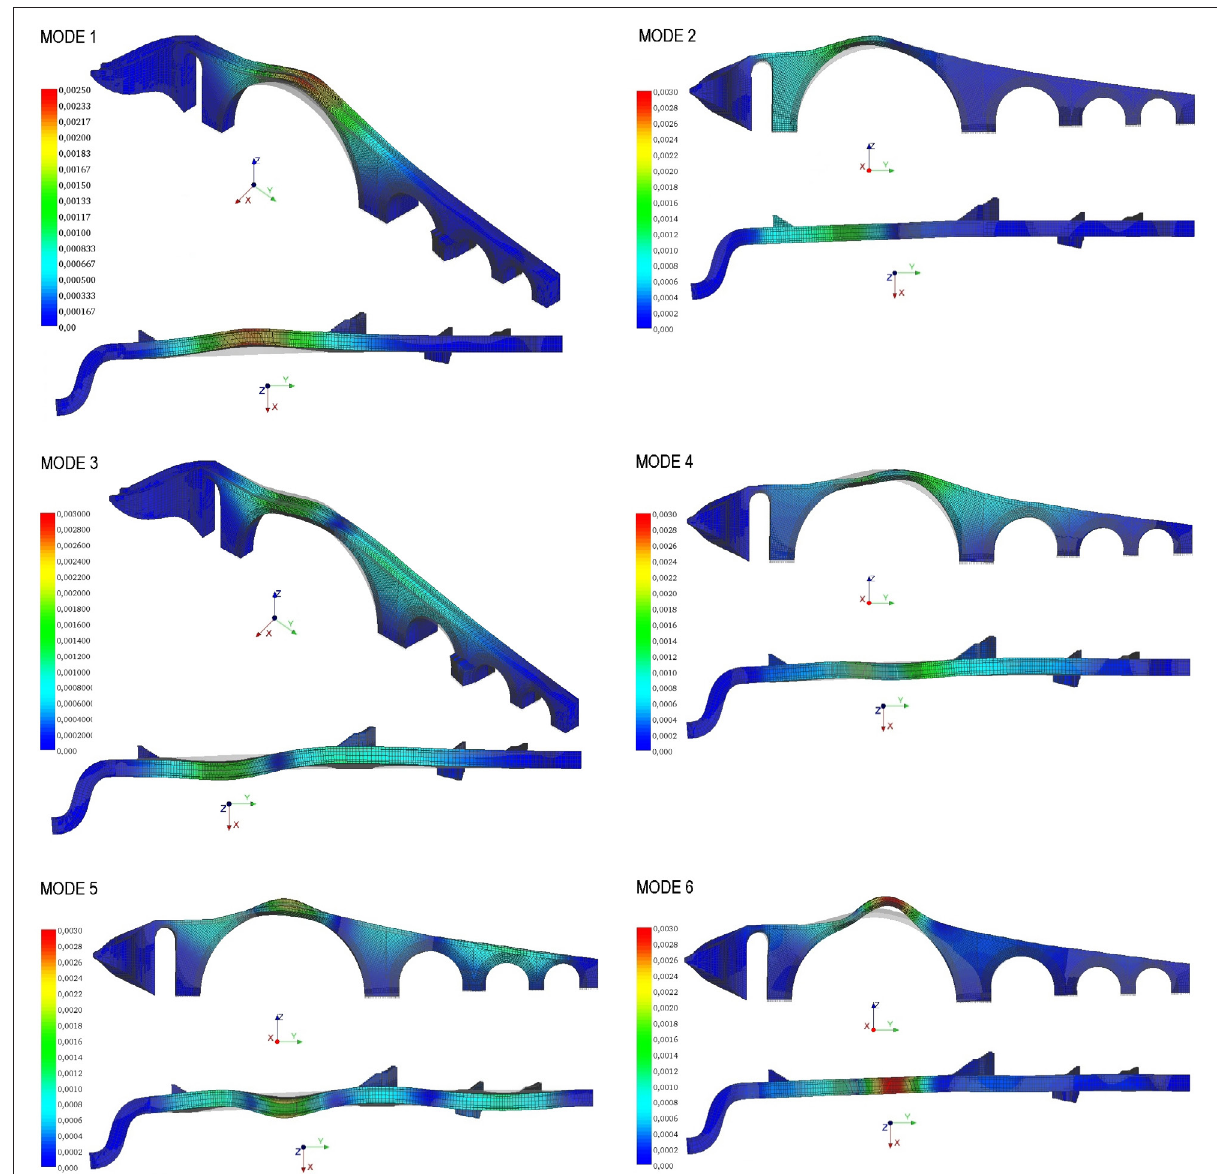
Figure 14. The bridge’s first six mode shapes calculated via the NOSA-ITACA